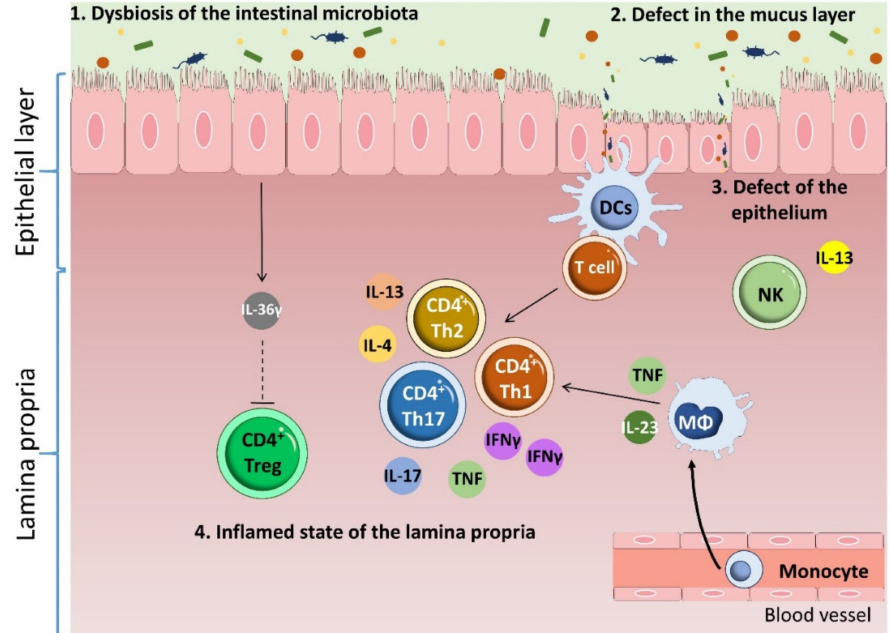
Figure 2. Pathophysiology of inflammatory bowel disease. Multiple factors contribute to IBD. Changes in the microbiota accompanied by thinning of the mucus layer induces a barrier breach that results in defects in the epithelium. Crossing of the barrier by microbiota components induces DC and macrophage activation, which induces infiltration of the intestinal tissue by inflammatory CD4 T cells. IBD patients have an increased content of proinflammatory Th1 and Th17 cells. This infiltration is accompanied by an increase in Th2 cell numbers and insufficient numbers of immune suppressing cells, such as Tregs. Inflammatory T cells guide the function of cells with an innate immune role, such as epithelial cells, fibroblasts and phagocytes, thus stimulating a constant hyperresponsiveness to microbial antigens and causing tissue injury and chronic intestinal